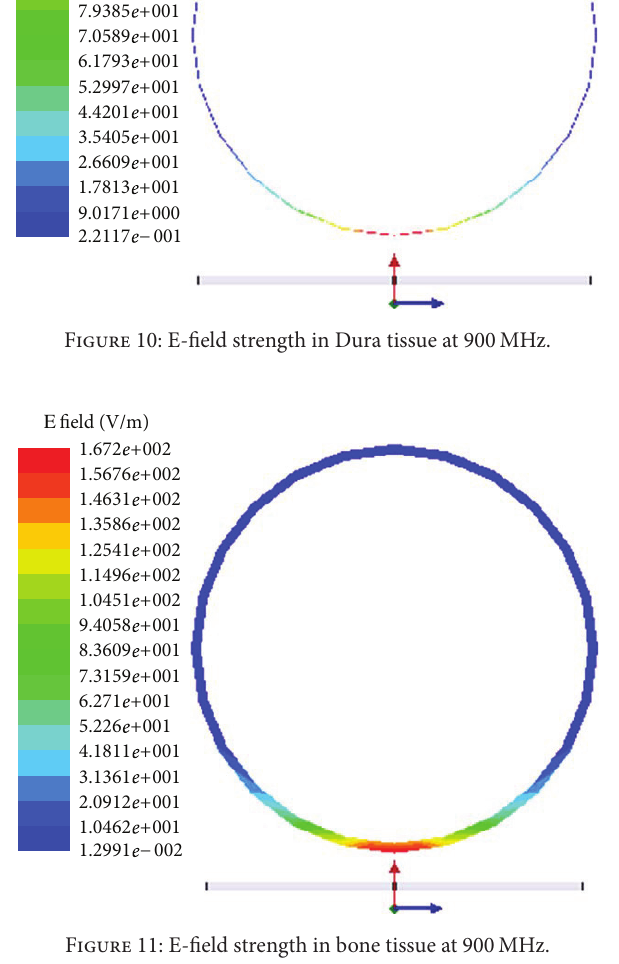
F 9: �-�eld strength in CSF tissue at 900���.